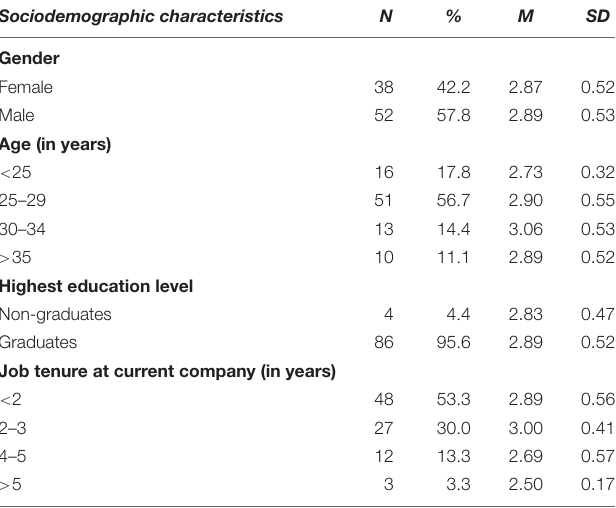
TABLE 1 | Sociodemographic characteristics of the polled